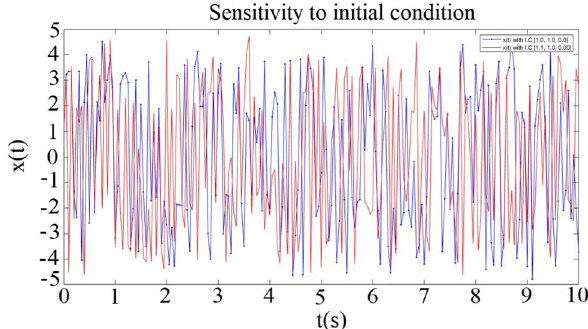
Fig. 3 The plot of sensitivity to initial conditions of Chaos for Chua’s